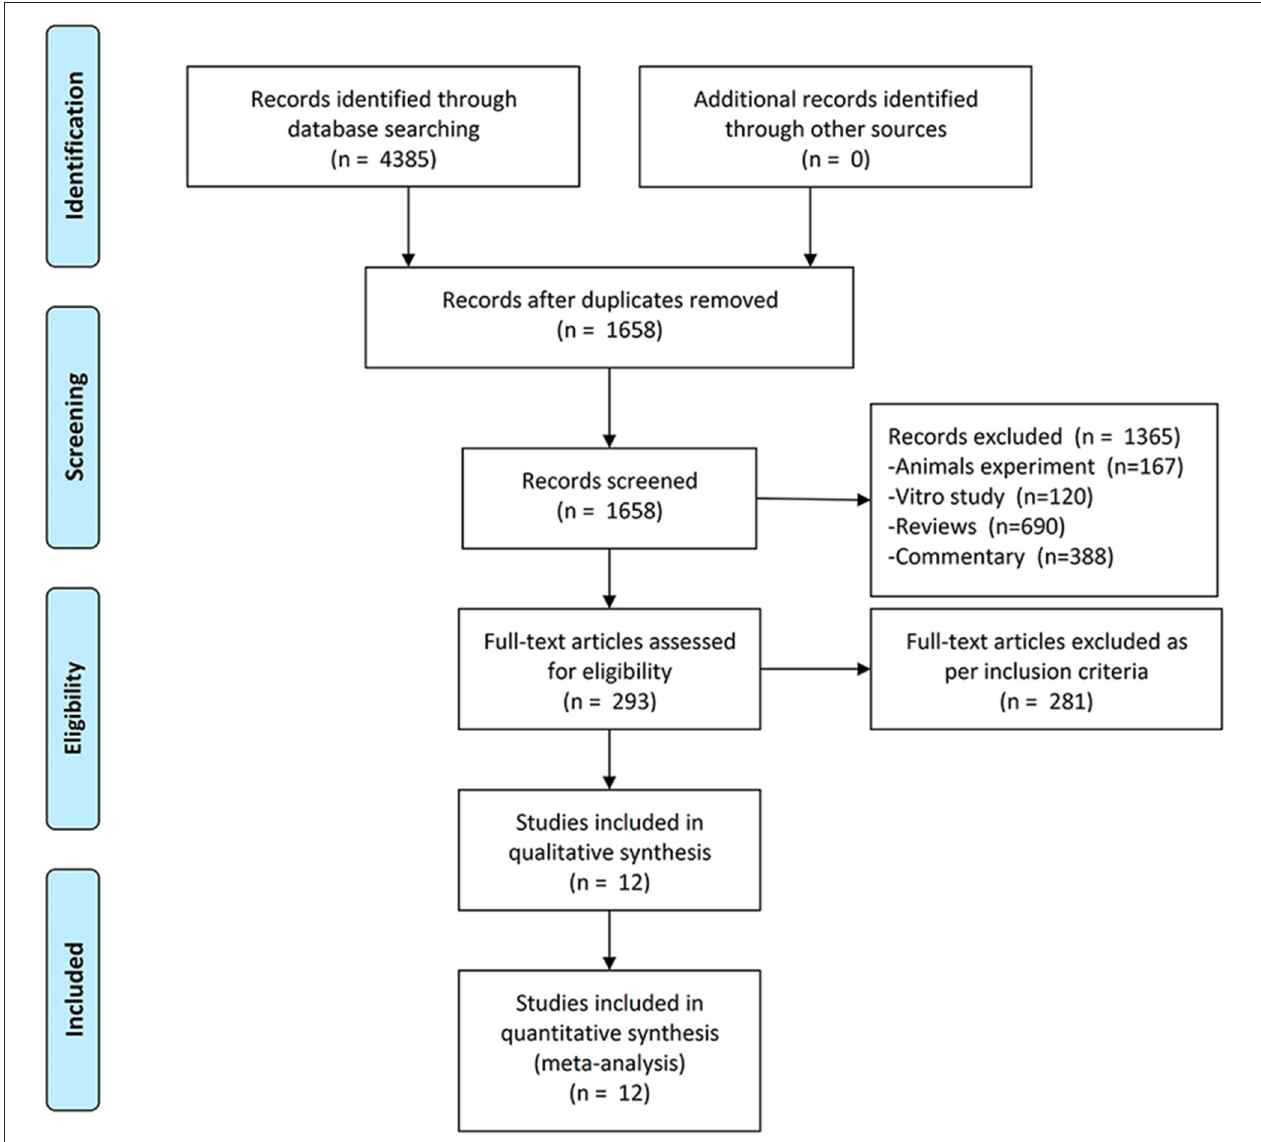
FIGURE 1 | PRISMA flow chart of study selection and